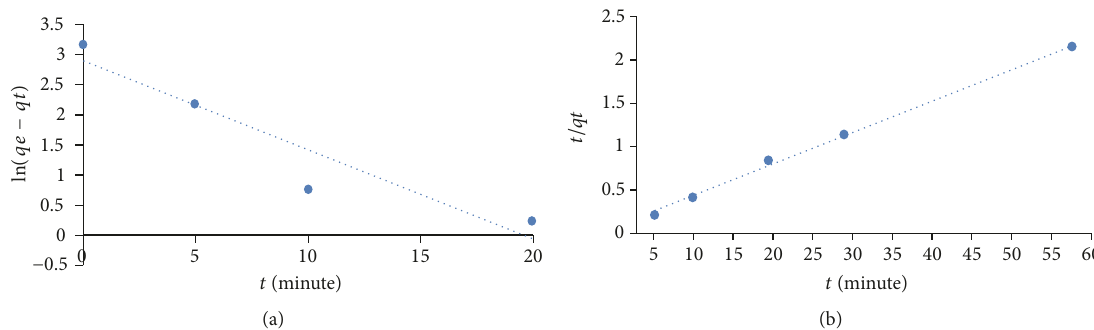
Figure 11: The adsorption kinetics of P(DEAMSt0.19-co-MMA): (a) first-order and (b) pseudo-second-order.